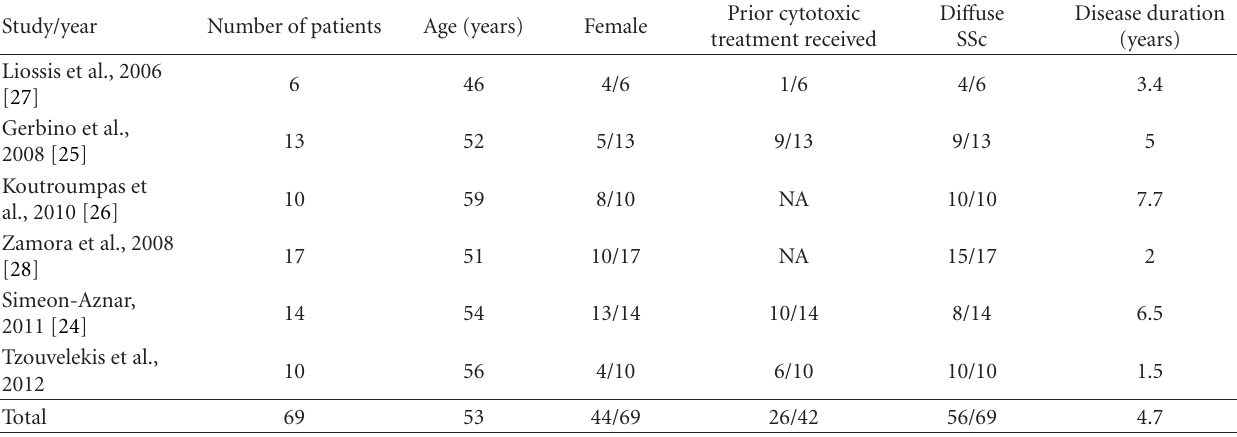
Table 1: Baseline characteristics of the patients included per study.